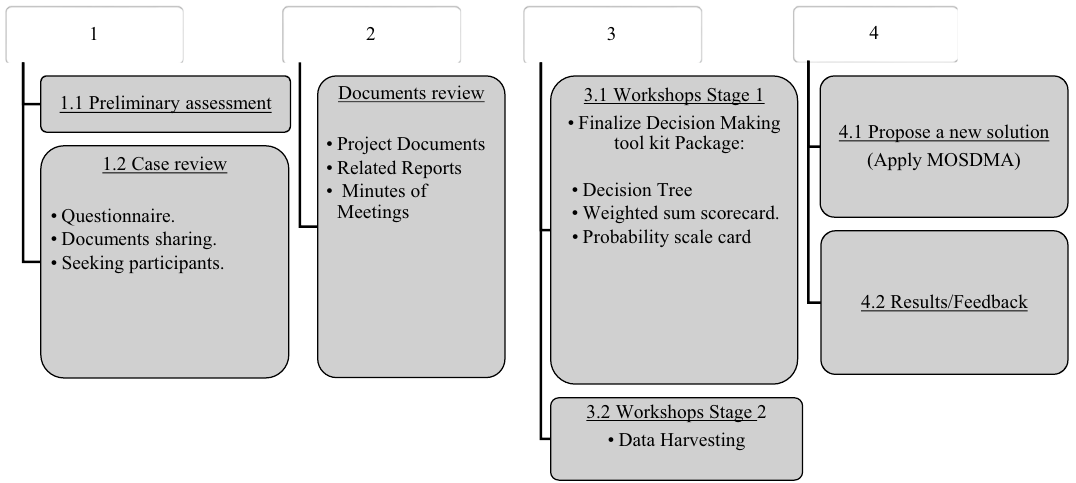
Fig. 1 Data gathering and methodology